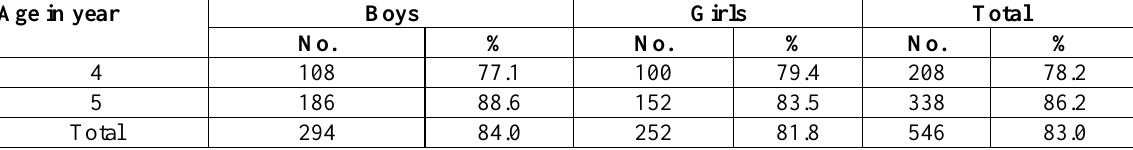
Table 2: Prevalence of dental caries among children by age and